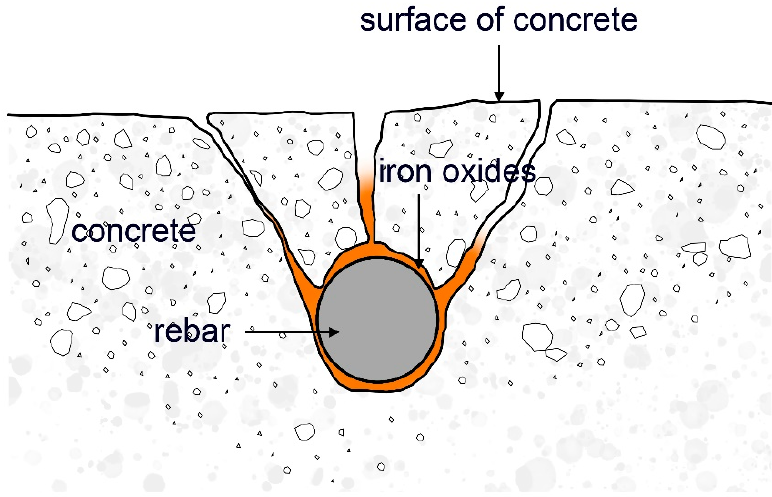
Figure 1. Cracking development and spalling of concrete cover due to oxides of steel reinforcement.